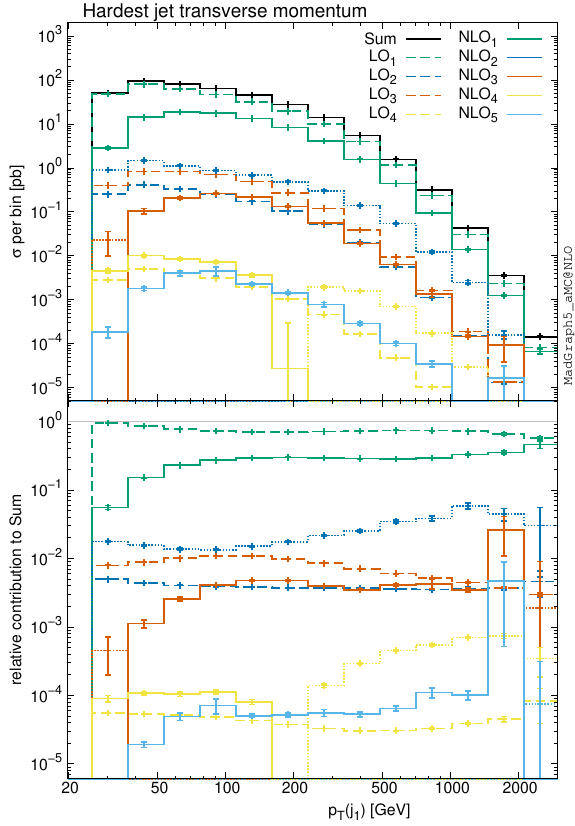
Figure 14. Transverse momentum of the hardest jet in pp ! t (cid:22) tj